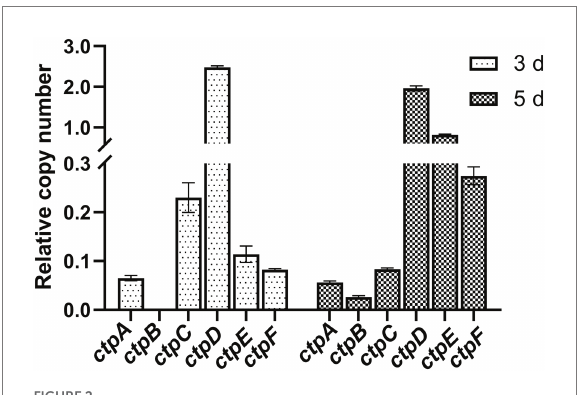
FIGURE 2 RT-qPCR analysis of ctpA to ctpF relative expression in S422 under citric acid fermentation conditions at 28 ° C, and 200 rpm for 3 days and 5 days, respectively. All expression values were normalized to the expression level of actA